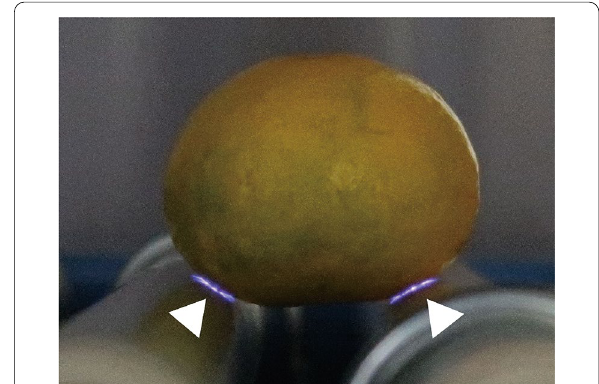
Fig. 7 Emission observed during APDBD treatment of citrus fruit. An emission (purple light) is clearly visible between the surface of the electrodes and C. unshiu (arrowheads) during APDBD treatment using the roller conveyor plasma instrument